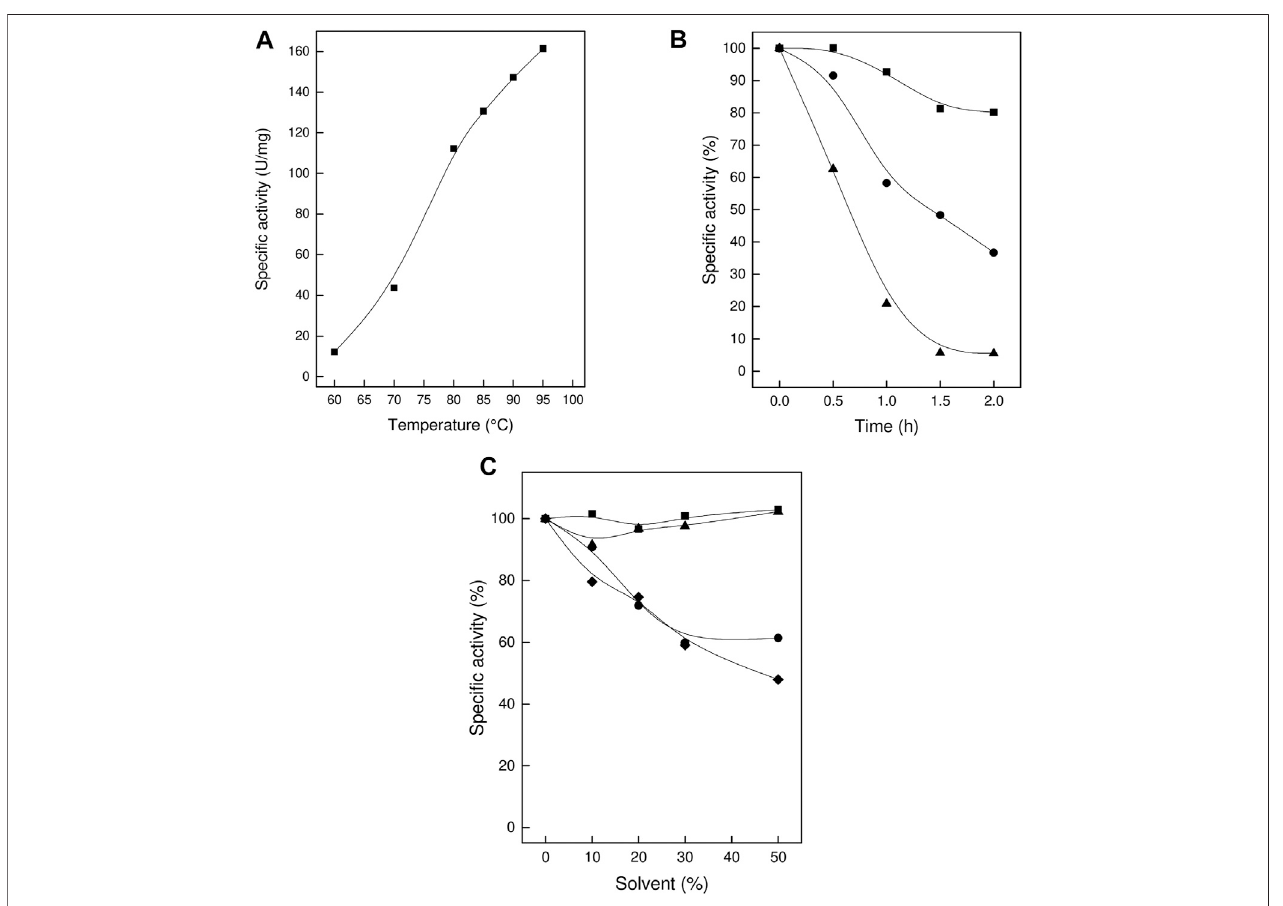
FIGURE 4 | Thermoactivity, thermostability and solvent stability of TsLI. (A) Speci fi c activity of D-lyxose isomerase measured between 60 and 95 ° C. (B) Residual activity of D-lyxose isomerase (in %) after preincubation for 2 h at 70 ° C ( ■ ), 80 ° C (C) and 90 ° C ( ▲ ) (100% 80 U/mg). The assays (600 µL) were performed in 50 mM Bis Tris buffer, pH 7.0, containing 1 mM MnCl 2 , 50 mM D-lyxose 6.7 µg enzymes. (C) Solvent stability. Residual activity (%) after 1 h incubation in the presence of the solvents (up to 50%) DMSO ( ■ ), ethanol (C) , methanol ( ▲ ) and acetonitrile ( ◆ ). (100% 110 U/mg). The assays (600 µL) were performed at 95 ° C in 50 mM BisTris buffer, pH 7.0, containing 1 mM MgCl 2 , 50 mM D-lyxose, and 6.7 µg enzyme.